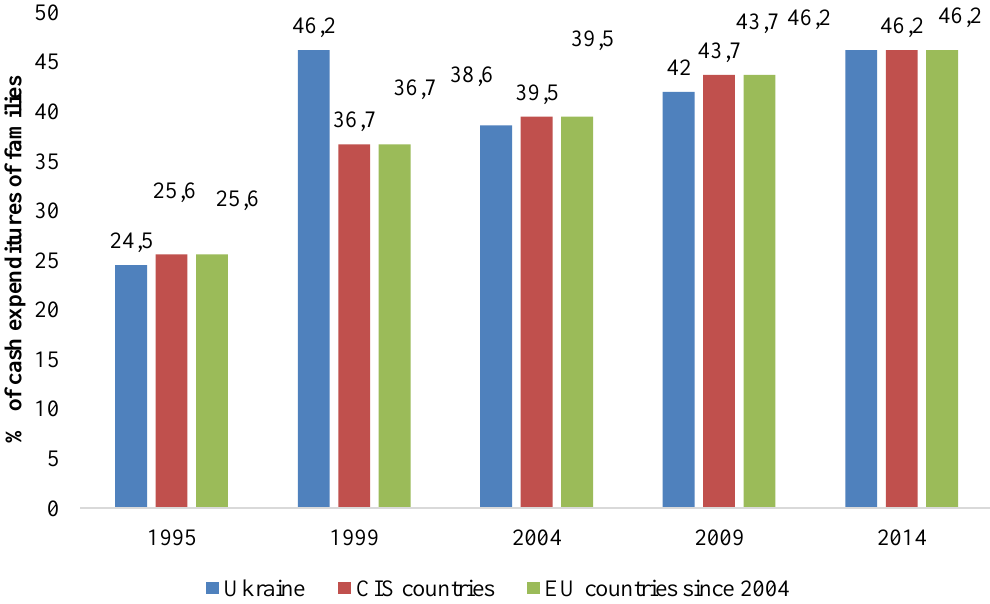
Fig. 2. Comparative analysis of the dynamics of families cash payments (%)for medical and pharmaceutical sup- port from the total cost of health care by indicative points (WHO data) First of all, the significant growth of “B” in 1999 sented macroeconomic indicator has almost doubled, and in Ukraine is noteworthy, compared to 1995. The pre- in the CIS and EU countries it has increased by 1.4